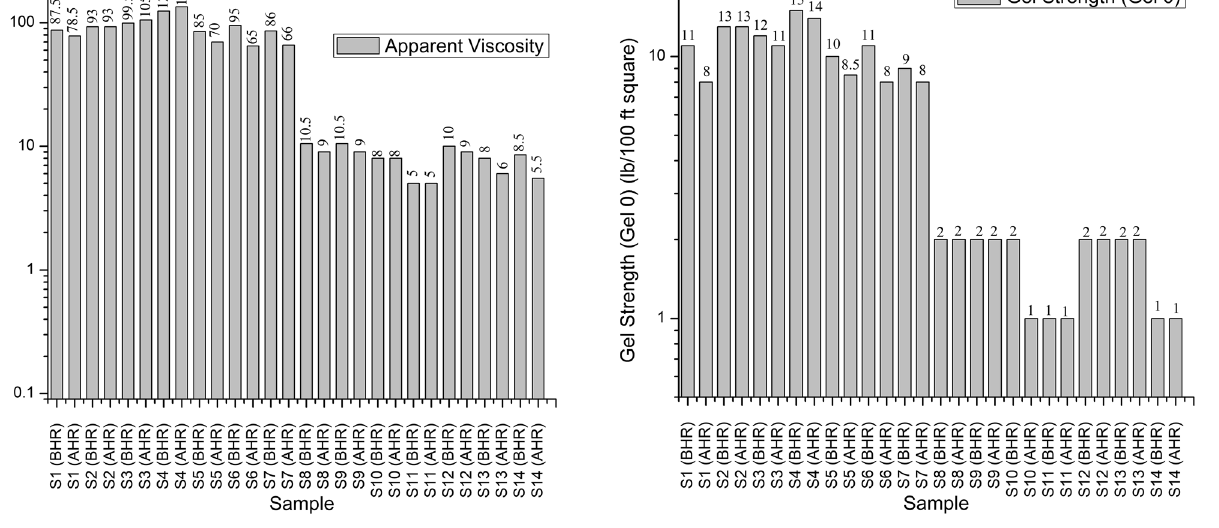
Fig. 5 Apparent viscosity of all the prepared drilling fluid samples Fig. 6 Gel strength (Gel 0) of all the prepared drilling fluid